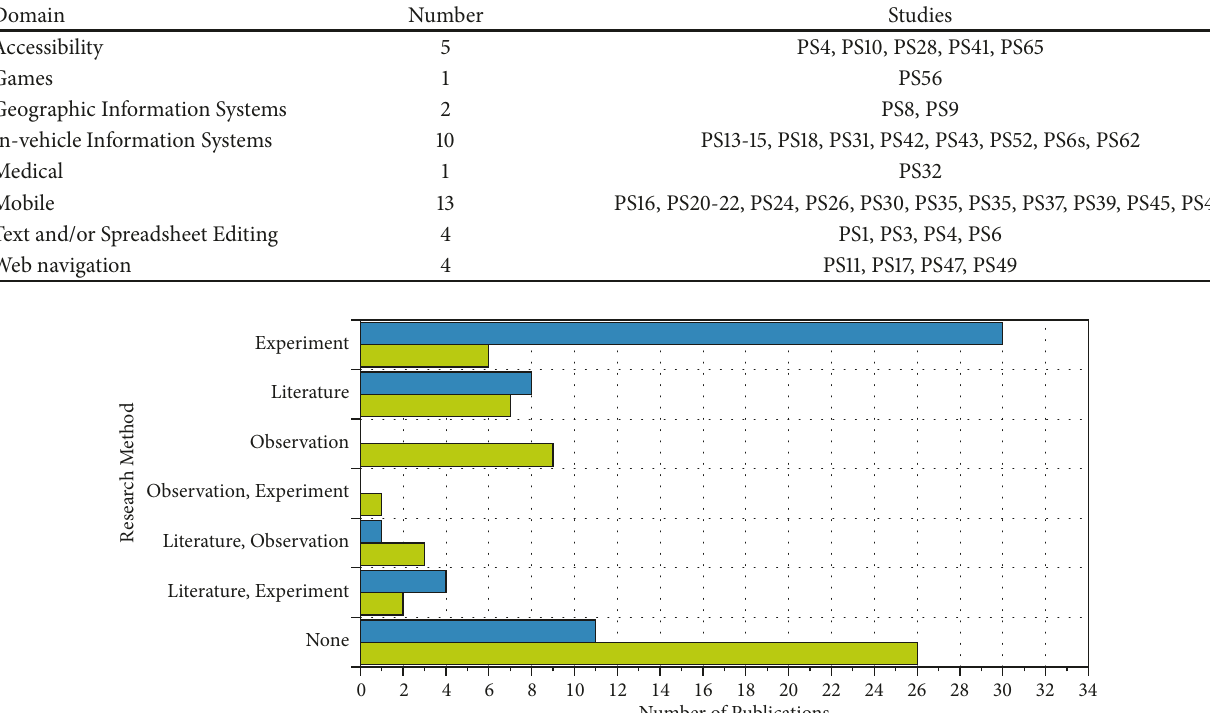
Table 10: Summary of recurrent domains from the primary studies.